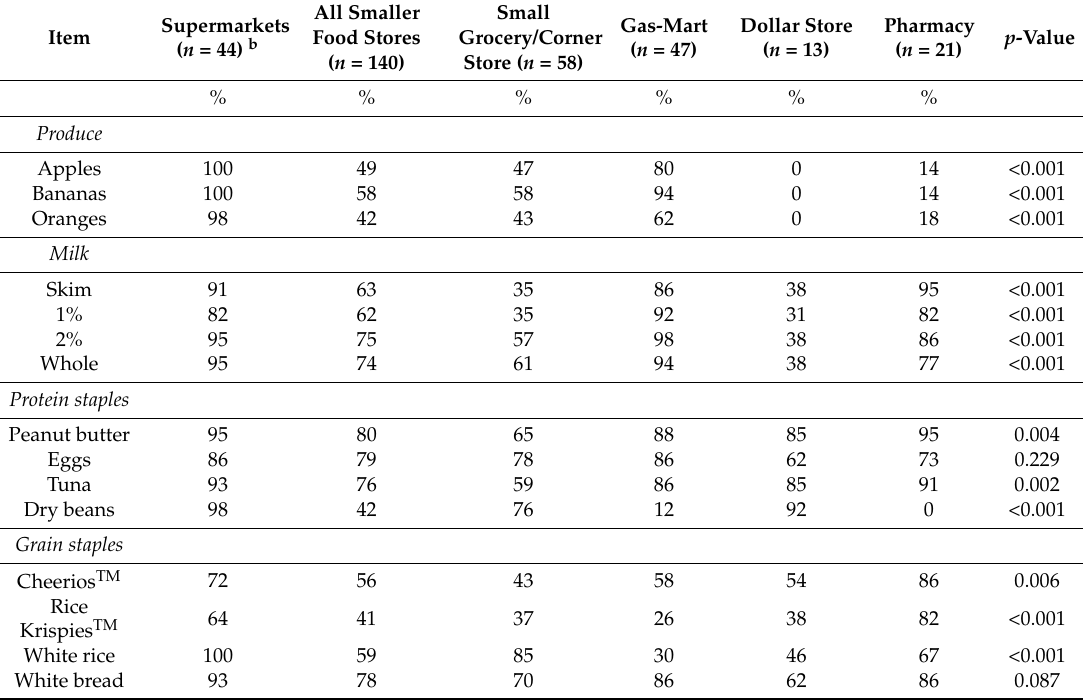
Table 1. Availability of items a at supermarkets, small food/corner stores, gas-marts, dollar stores, and pharmacies, Minneapolis and St. Paul, MN, 2014.